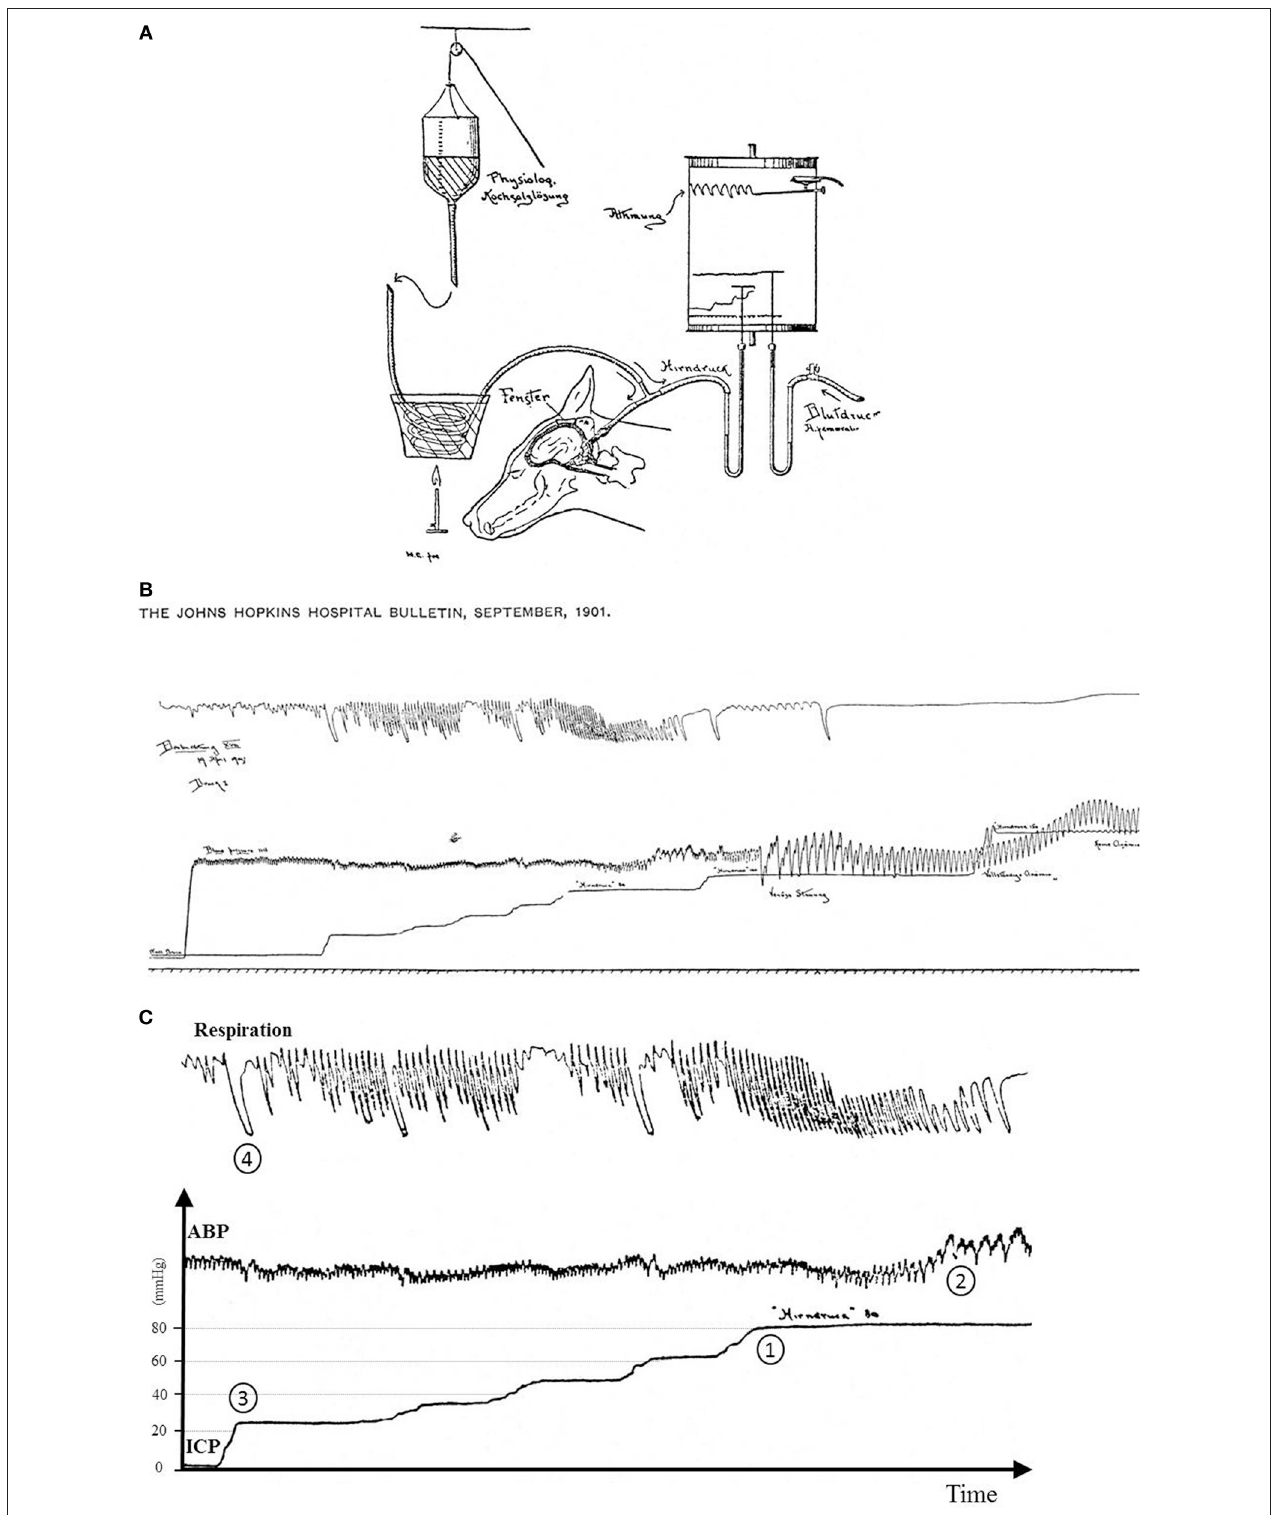
FIGURE 8 | (A) Sketch of the original experimental setting from Cushing (1901). A needle was inserted in the cisterna magna of a dog to measure the CSF pressure assumed to be the pressure in the brain ( Hirndruck ). The needle connected via a tube to a bottle filled with warm saline ( physiologische Kochsalzlösung ). ABP